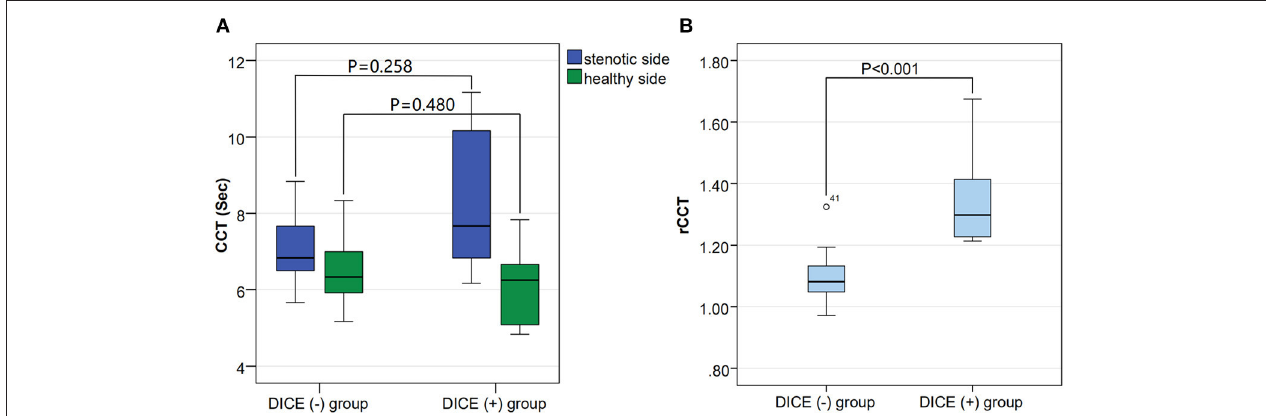
FIGURE 2 | Comparison of the stenotic side CCT (sCCT), the healthy side CCT (hCCT) and the relative CCT (rCCT) among the DICE (–) and DICE ( + ) groups. (A) shows no difference in hCCT [6.33 (5.92, 7.00) vs. 6.25 (4.96, 7.25), p = 0.480] and sCCT [6.83 (6.50, 7.75) vs. 7.67 (6.50, 10.67), p = 0.258] between the DICE (–) and DICE ( + ) groups. (B) shows a significant difference in rCCT (1.37 ± 0.19 vs. 1.09 ± 0.07, p < 0.001) between the DICE (–) and DICE ( + ) groups.